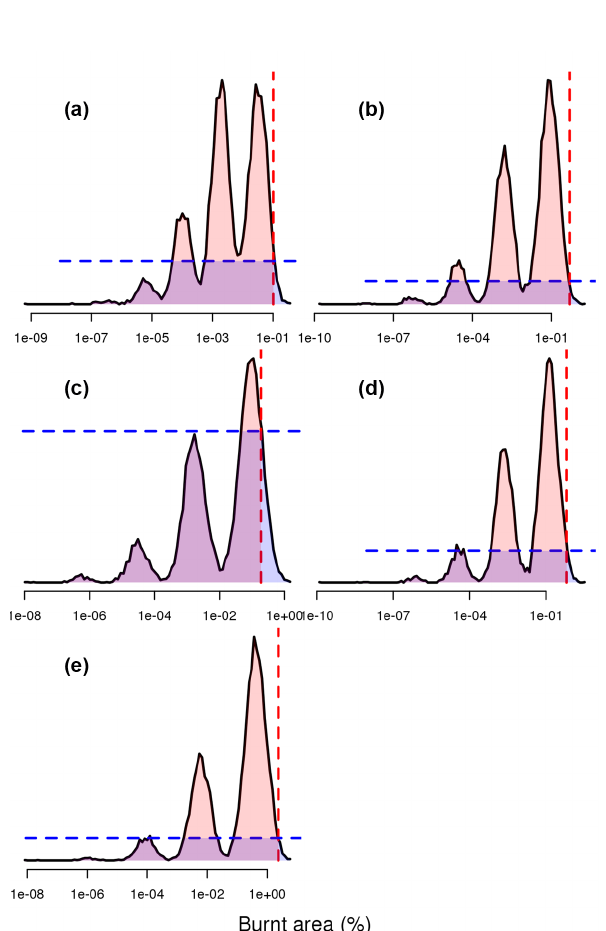
Figure B1. Full model posterior solution (black line) for August 2005 across each of the sub-regions compared to MODIS Collection 6 MCD64A1 burnt area product (Giglio et al., 2018) (red dashed line). Red shaded area (posterior solution smaller than observed) shows the likelihood high burnt areas were influenced by factors external to the modelling framework. Blue shaded area is the area of the posterior which has less chance of occurrence than the observed burnt area (given by blue dashed line).